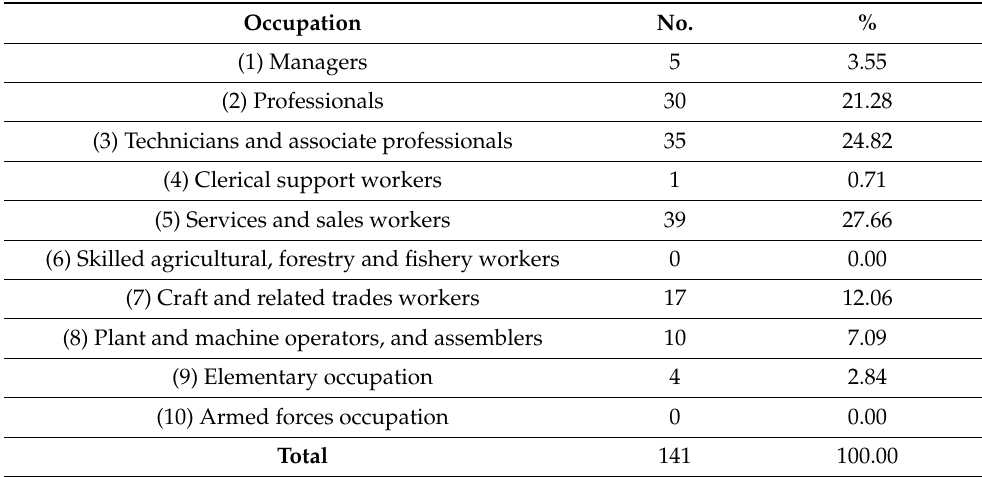
Table 2. Occupational positions, according to the International Standard Classification of Occupations version 08